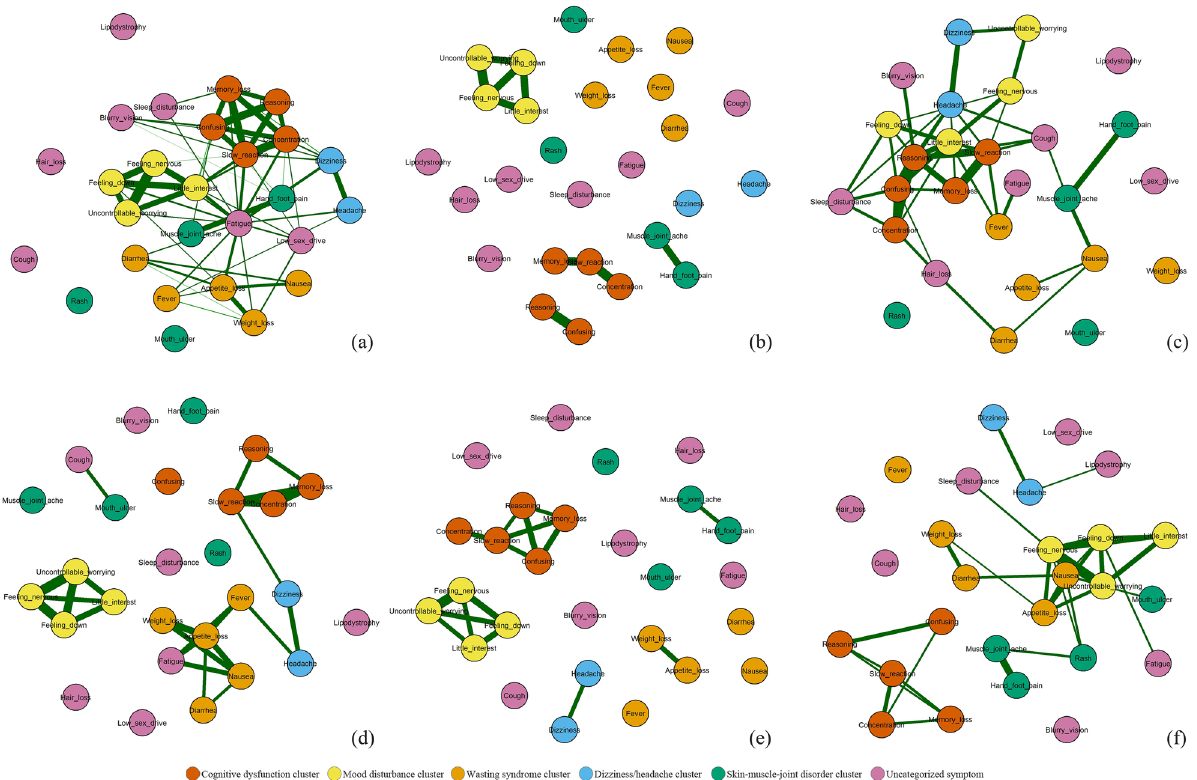
Figure 2. Symptom network in the full sample and 5 subgroups: ( a ) full sample, ( b ) Profile 1, ( c ) Profile 2, ( d ) Profile 3, ( e ) Profile 4, and ( f ) Profile 5. Red nodes represent cognitive dysfunction cluster; yellow nodes represent mood disturbance cluster; orange nodes represent wasting syndrome cluster; green nodes represent skin-muscle-joint disorder cluster; pink nodes represent uncategorized symptoms. In the Fruchterman-Reingold algorithm, the node with the strongest centrality was placed in the center of the network. The thickness of edges corresponds to the strength of